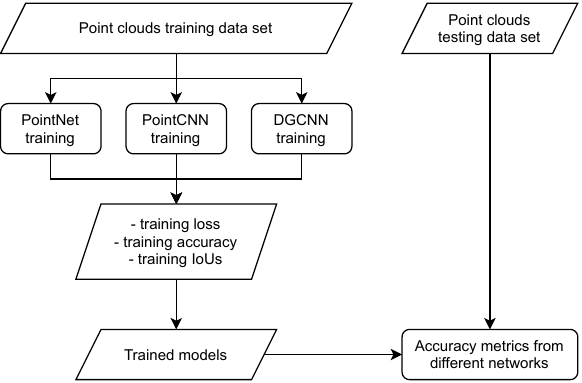
Figure 4. Flowchart of the experiments conducted in this study. the objects in our scenes to have different dimensions from that of S3DIS.